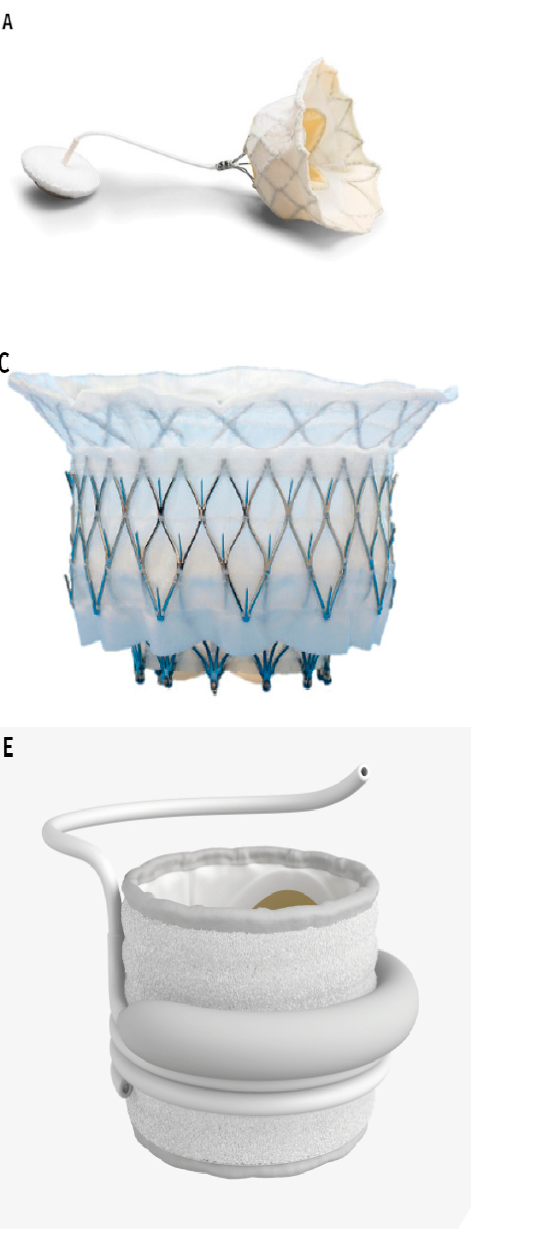
Figure 2. Transcatheter Mitral Valve Replacement Systems: ( A ) Tendyne prosthesis. Image courtesy of Abbott. ( B ) Tiara prosthesis (left: top view, right: side view). Image courtesy of Neovasc Inc. ( C ) Intrepid prosthesis. Image courtesy of Medtronic. ( D ) EVOQUE prosthesis. Image courtesy of Edwards Lifesciences. ( E ) SAPIEN M3 prosthesis. Image courtesy of Edwards Lifesciences. ( F ) HighLife prosthesis. Image courtesy of HighLife Medical.